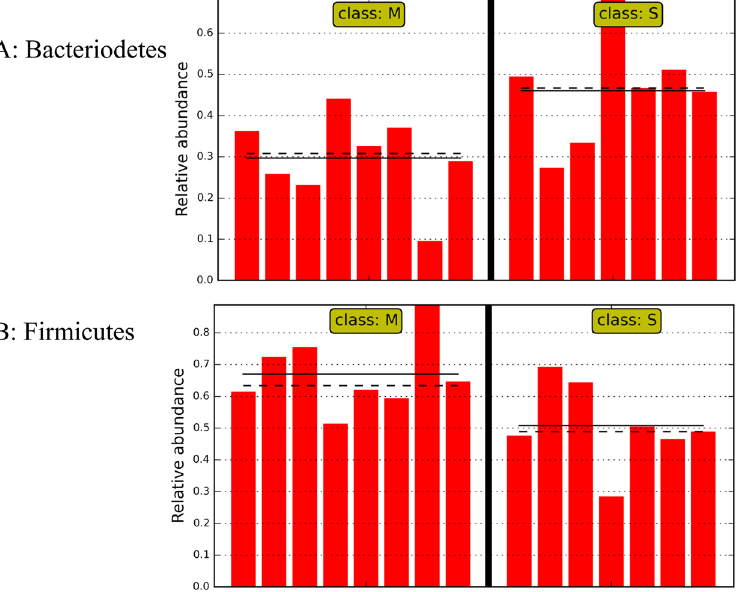
Figure 8. The two most abundant phyla, Bacteroidetes and Firmicutes, were significantly impacted by CS disaccharide supplement in the mice subjected to exhaustive exercise stress. M: mice subjected to exhaustive exercise stress + PBS; S: the stressed mice supplemented with a daily dose of 150 mg/kg bodyweight of CS disaccharides for 16 days. Straight line: group mean abundance. Dotted Line: median.